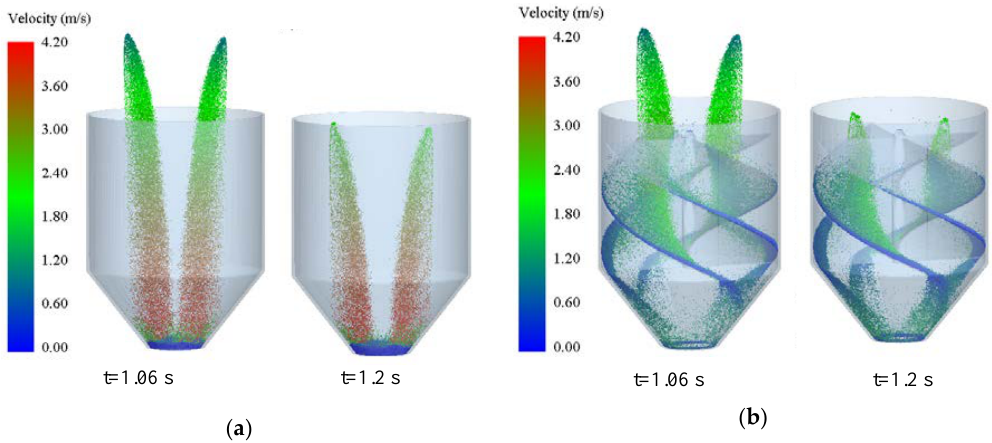
Figure 4. Particle distribution of ( a ) conventional hopper; ( b ) spiral hopper at DEM simulations. Particles are colored by velocity magnitude.